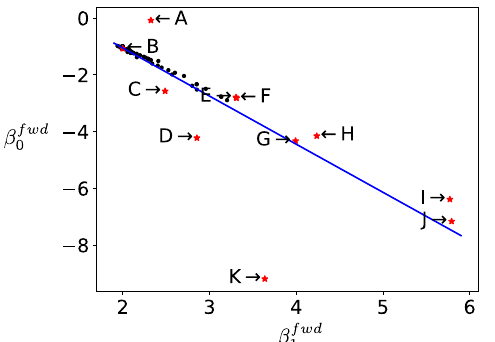
Figure 7. Regression coefficients (in dots or stars) of linear regression for non-conformal map projections. Capital letters represent Tobler-Mercator (A), Bonne ( ϕ 1 = 30 ◦ ) (B), Lambert equal area conic (C), Albers equal area ( ϕ 1 = 20 ◦ , ϕ 2 = 60 ◦ ) (D), Nell (E), Hatano asymmetrical equal area (F), Eckert II (G), general sinusoidal series ( m = 2, n = 3) (H), Urmaev FPS (I), Urmaev V (J), and Lambert azimuthal equal area (K) projections.